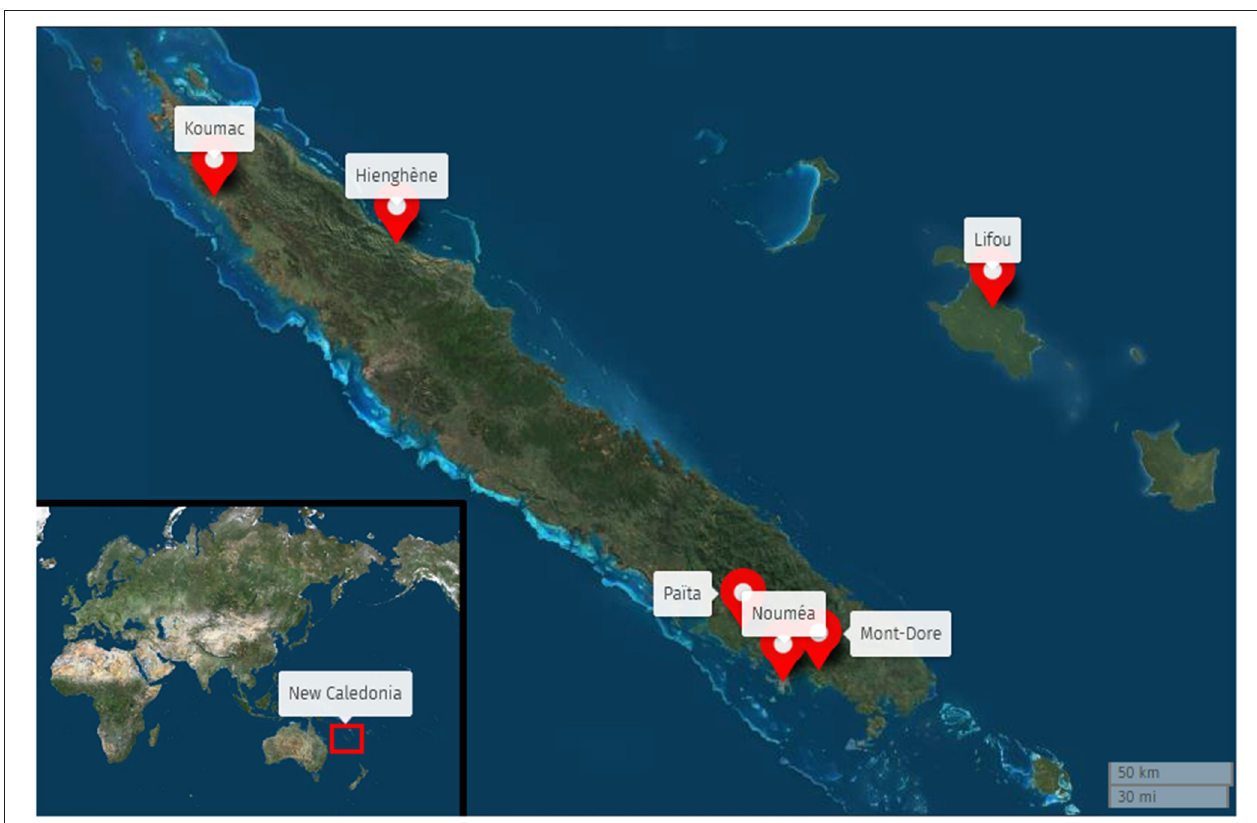
FIGURE 1 | Towns and villages (Koumac, Hienghène, Lifou, Païta, Nouméa, and Mont-Dore) that had schools involved in the study on a New Caledonia